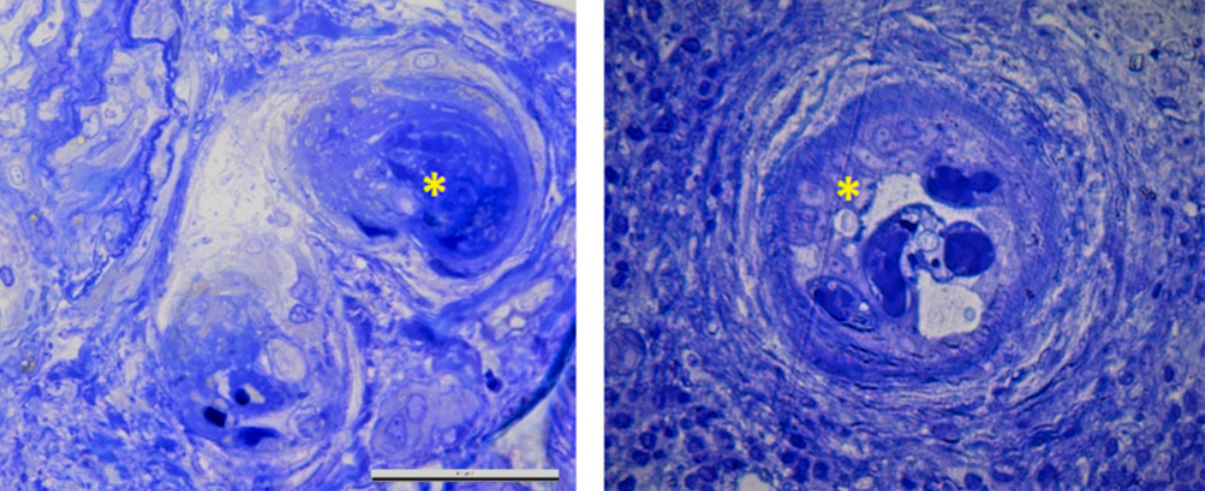
Figure 3. Light microscopy. Thrombus inside an arteriole (yellow asterisk) sustaining the diagnosis of renal thrmboticmi ‐ croangiopathy (blue toluidine, 40× magnification).